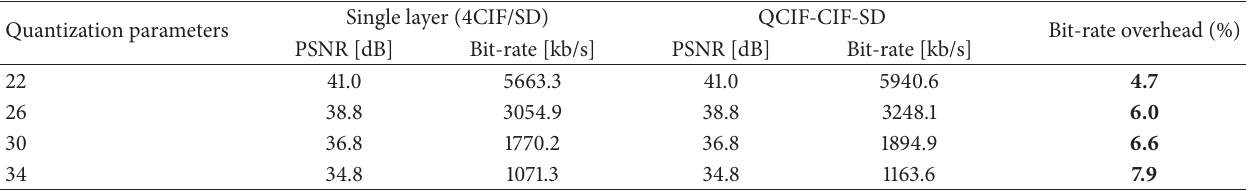
Table 3: Three-layer (QCIF-CIF-SD) spatial scalability coding versus single layer (4CIF/SD) coding (“ SOCCER ” video sequence, 30fps, 300 frames, GOP size is